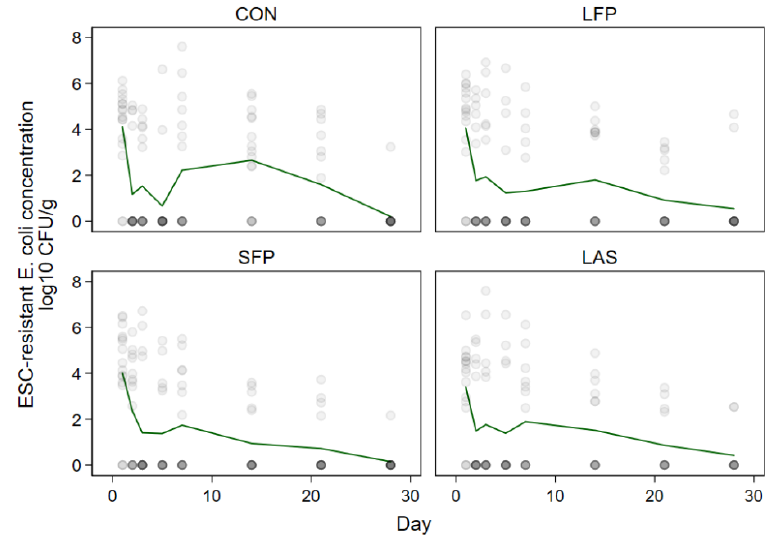
Figure 2. Mean concentration of ESC-resistant E. coli in pig rectal swabs ( n = 16 per timepoint) belonging to different dietary treatment groups. Mean concentration is represented by the line with dots representing individual pigs (overlapping of individual pig data results in darker dots in graph). Treatment abbreviations: CON: control diet, LFP = CON + 2000 ppm Lactobacillus acidophilus fermentation product (LFP), SFP = CON + 2000 ppm Saccharomyces cerevisiae fermentation product (SFP), LAS = CON + 2000 ppm LFP + 2000 ppm SFP.